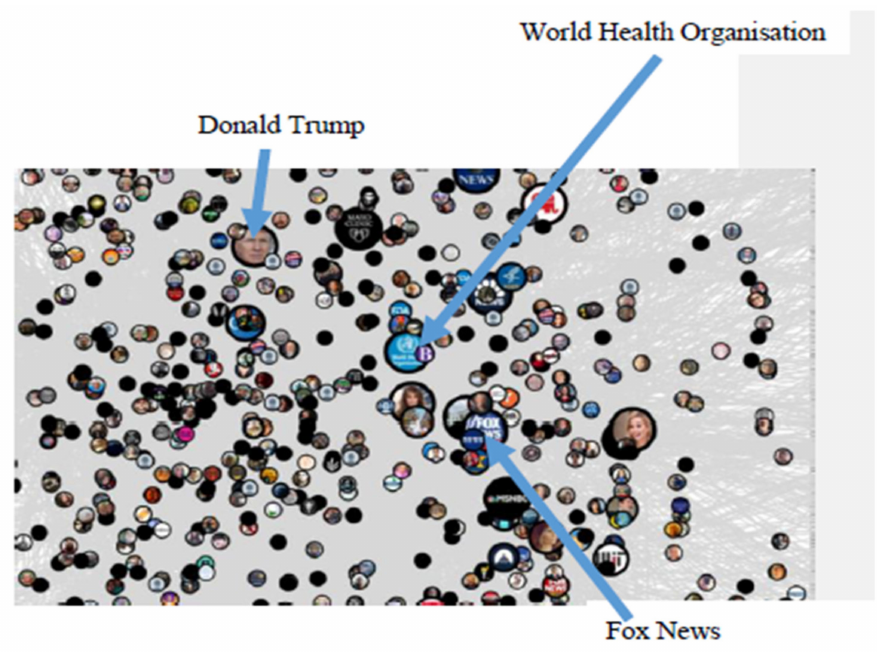
Figure 2. Zooming into Group 2.